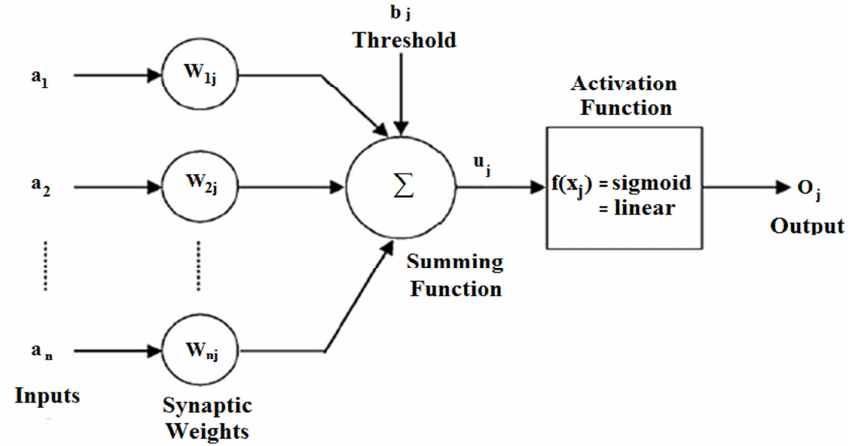
Figure 2. Single node anatomy jin ∑ baWu +·= )( ijj = i